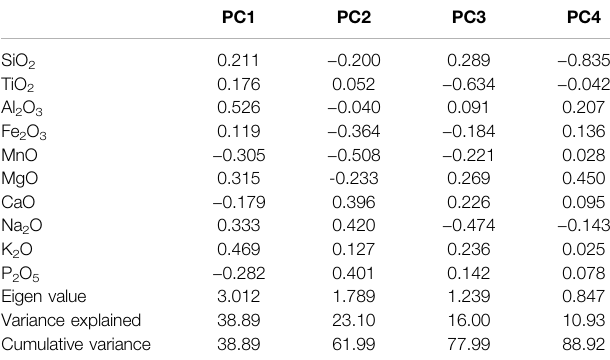
TABLE 2 | Results of principal component